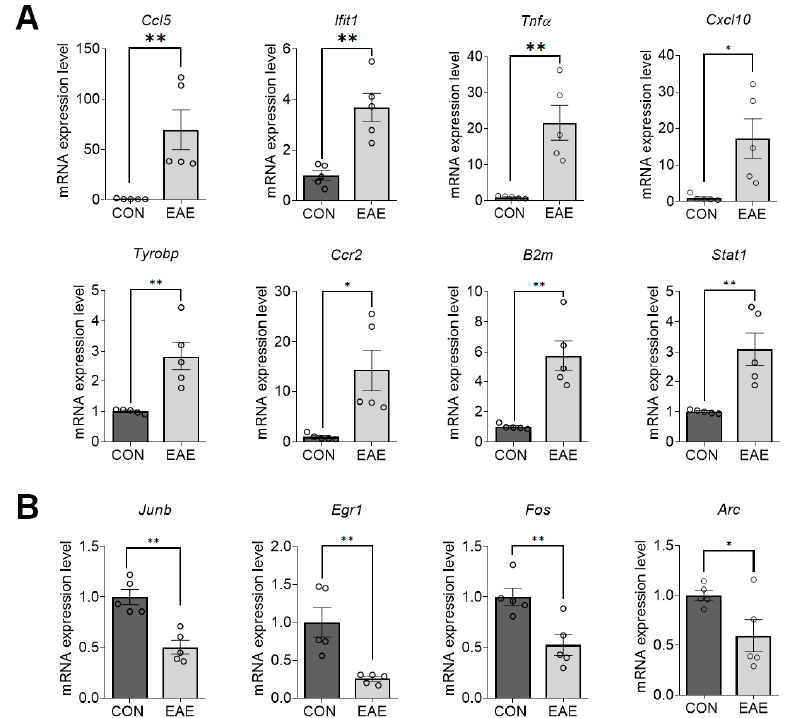
Figure 3. Changes in 12 selected differentially expressed genes (DEGs) in the hippocampi of mice with EAE. The bar graphs show the relative expression levels of upregulated ( A ) and downregulated ( B ) genes from RNA-seq data. Data are expressed as the mean ± SEM ( n = 5/group). * p < 0.05 and ** p < 0.01 vs. the CON group.